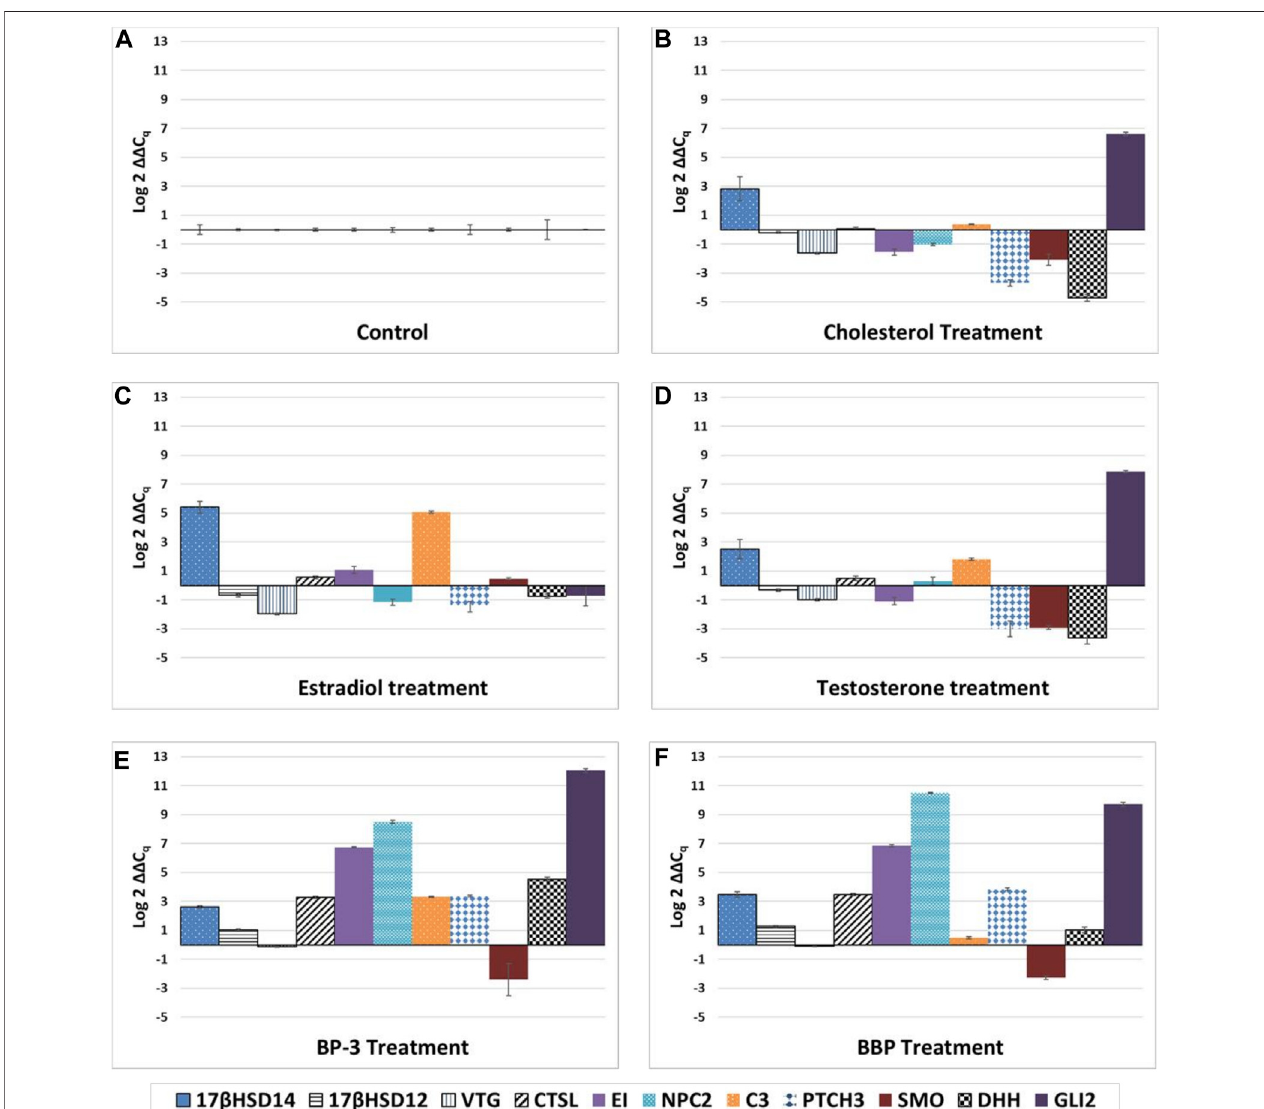
FIGURE 4 | Unique expression pro fi les for each treatment. (A) control, (B) cholesterol, (C) estradiol, (D) testosterone, (E) oxybenzone, (F) benzyl butyl phthalate. The ΔΔ Cq values represent transformed expression of GOI relative to RPL11 expression. Error bars represent ± SE.